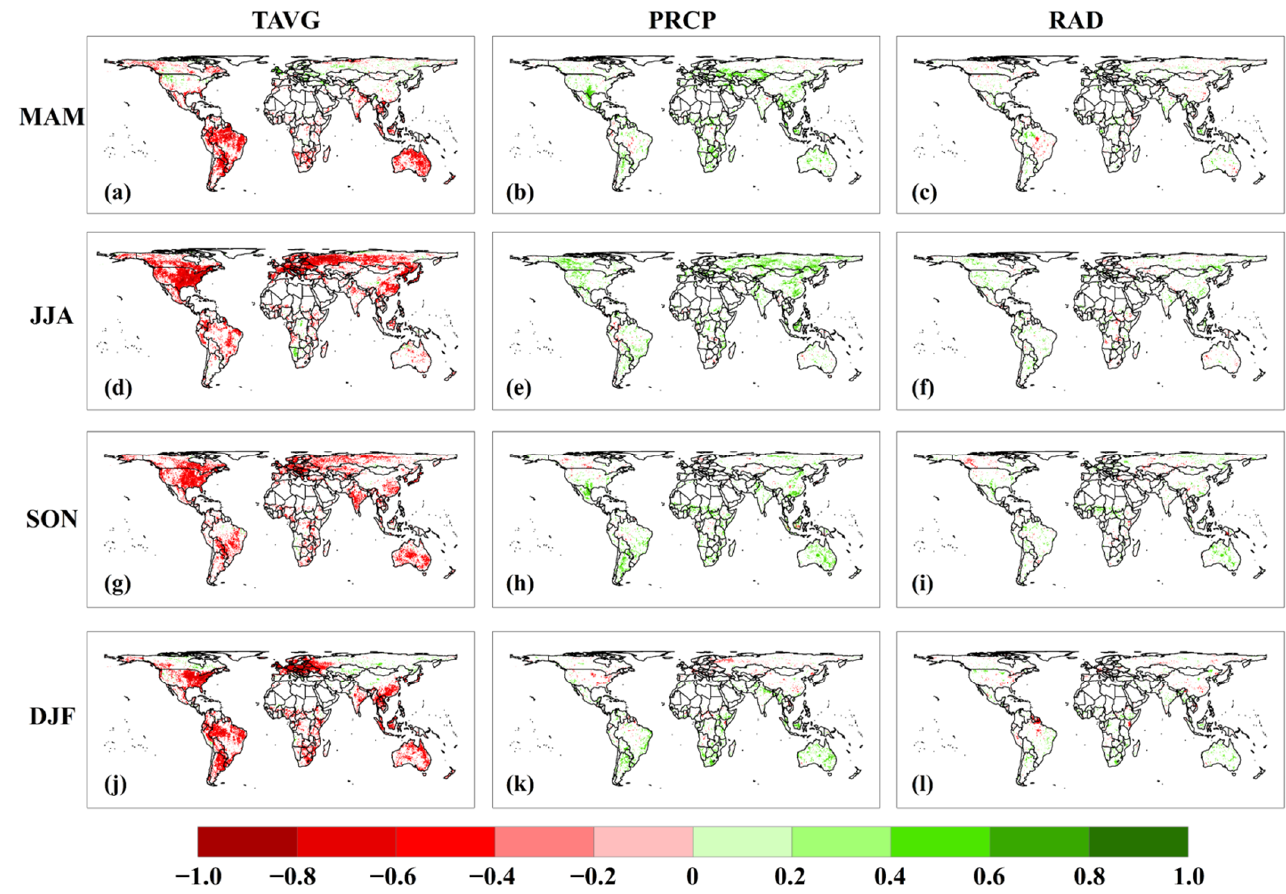
Figure 11. The partial correlation between anomalies of detrended NEP and TAVG, PRCP, and RAD in ( a – c ) MAM, ( d – f ) JJA, ( g – i ) SON, and ( j – l ) DJF. Shown are significant correlation regions ( p <